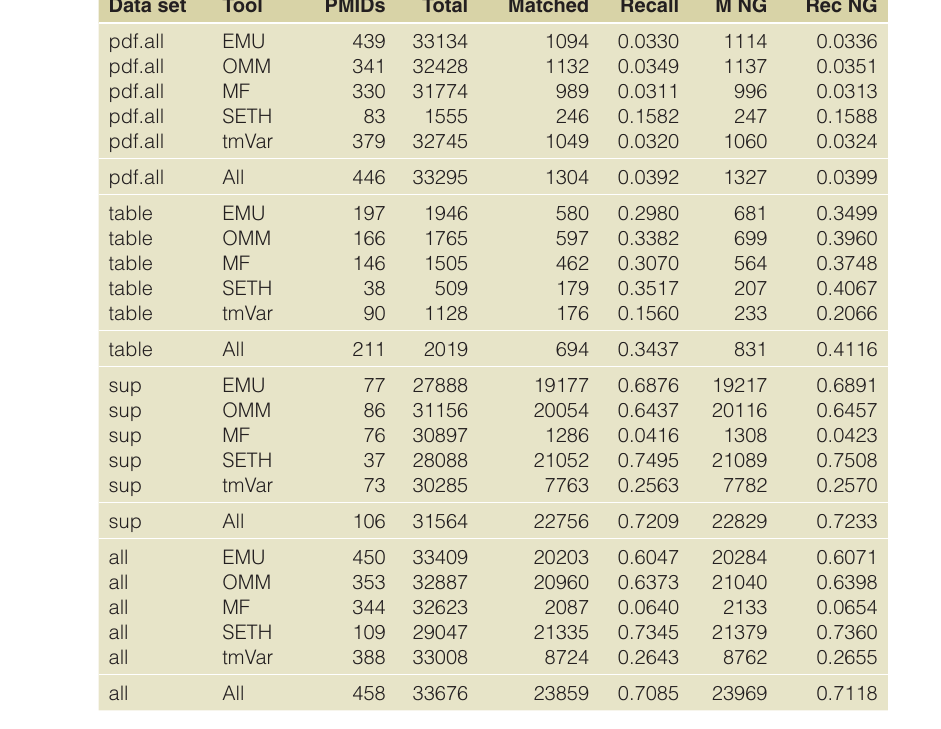
Table 11. InSiGHT variant extraction coverage result when only articles with variants in the reference set as well as at least one result identified by the information extraction tool are considered. The table shows the number of common articles (PMIDs), the number of variants in the reference set (Total), the number of matched variants by the mutation extraction tool (Matched) and the proportion of matched variants (Recall). When relaxing the gene matching (M NG), the results do not change, thus this data is not shown. The data sets considered are MEDLINE abstracts (medline), Open Access PMC articles (pmc.ft), PDF articles when no Open Access PMC articles are available (pdf), PDF representation for all the articles (pdf. all), tables available from the Open Access PMC Articles’ XML (table), supplementary material (sup) and the combination from all the sources (all). The tools are Extractor of Mutations (EMU), OpenMutationMiner (OMM), MutationFinder (MF), tmVar and SNP Extraction Tool for Human Variations (SETH). The row with tool value as All indicates the result when the variants extracted by all the tools are